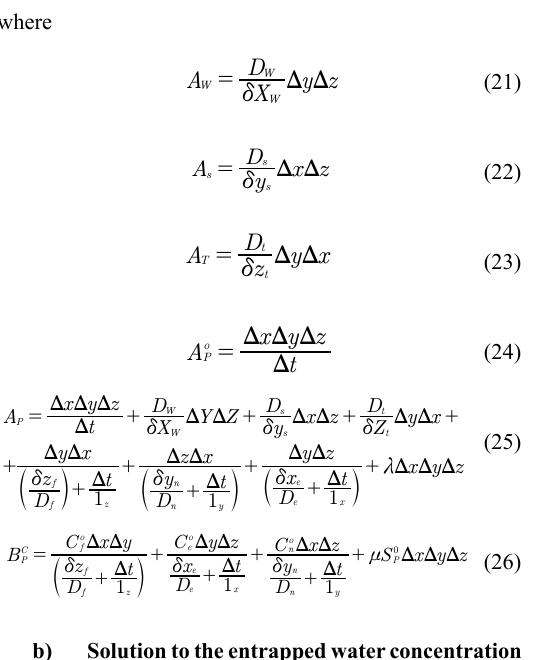
As an application, a specific isothermal case was selected to be studied (T=25ºC). Table 1 shows the data used in the simulation (D=7.31787 x 10 -12 m 2 /s, µ = 3.27972 x 10 -6 s -1 and λ = 2.12852 x10 -6 s -1